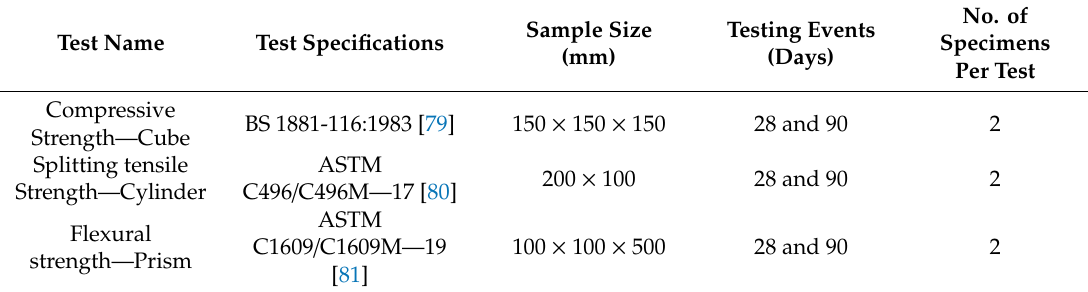
Table 6. Summary of the experimental investigation—mechanical